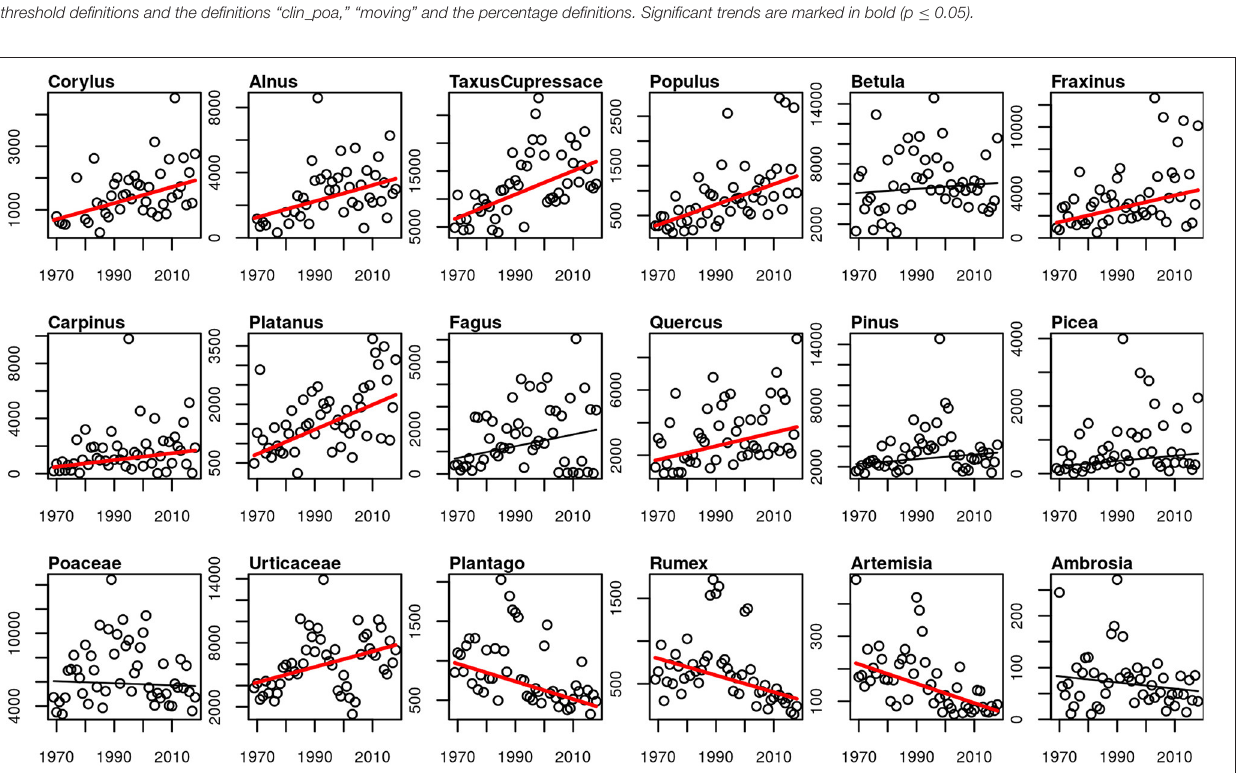
pollen season, for the definitions of the last date of 3 consecutive days with 1 pollen/m 3 and the last date with 5 consecutive days with 1 pollen/m 3 . Also, the “perc90” definition gives a